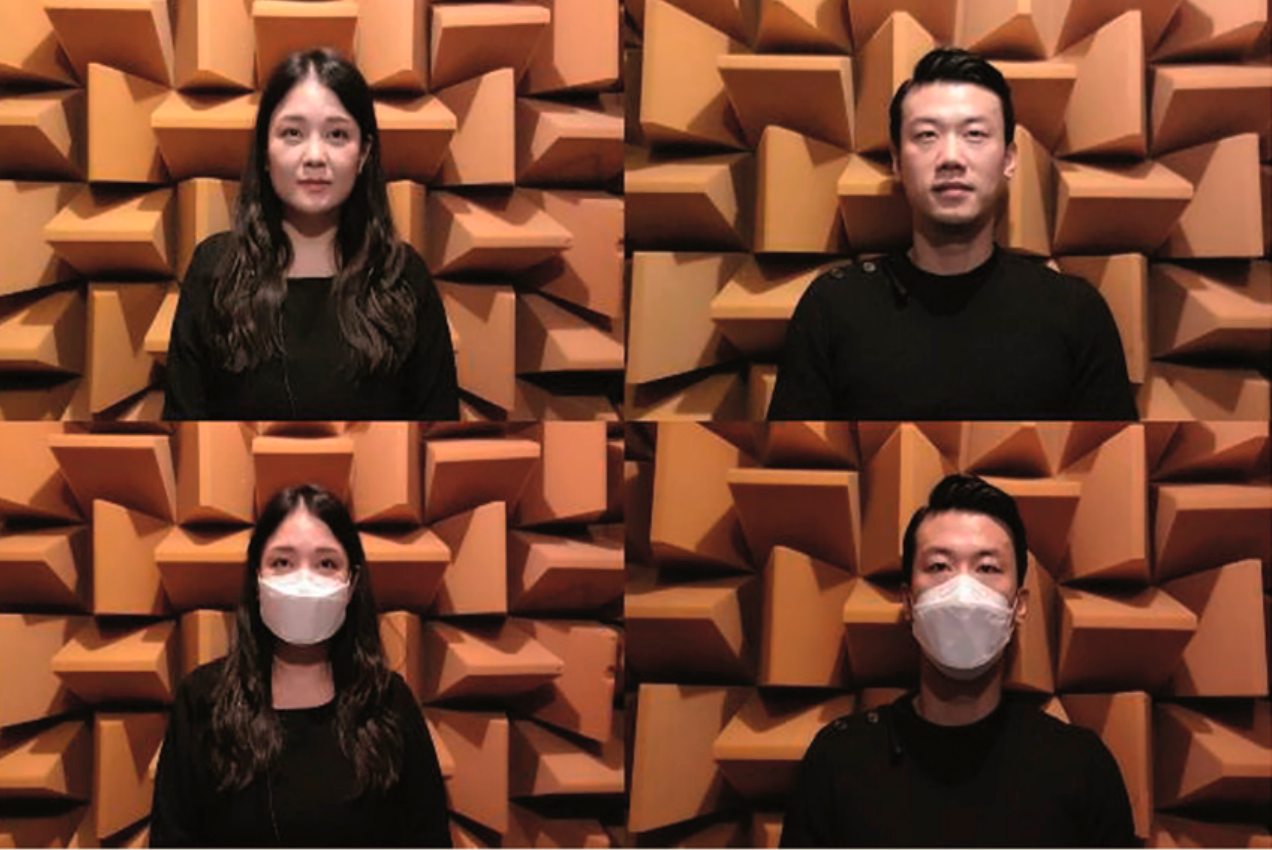
Figure 1. Screenshot of the video recordings used in the study.